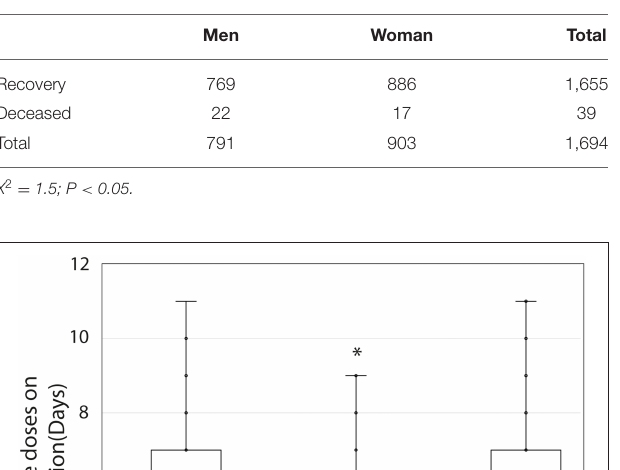
TABLE 2 | Prevalence of symptomatology by patients in the three periods analyzed.